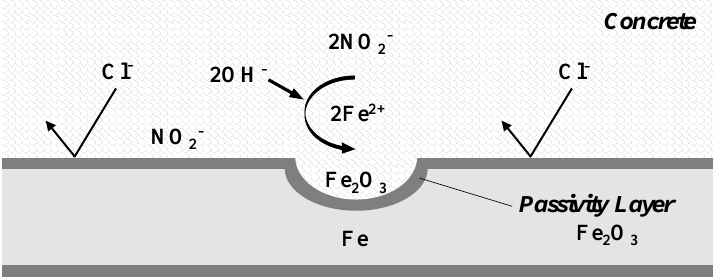
Figure 1. Anti-corrosive mechanism of nitrite-based corrosion